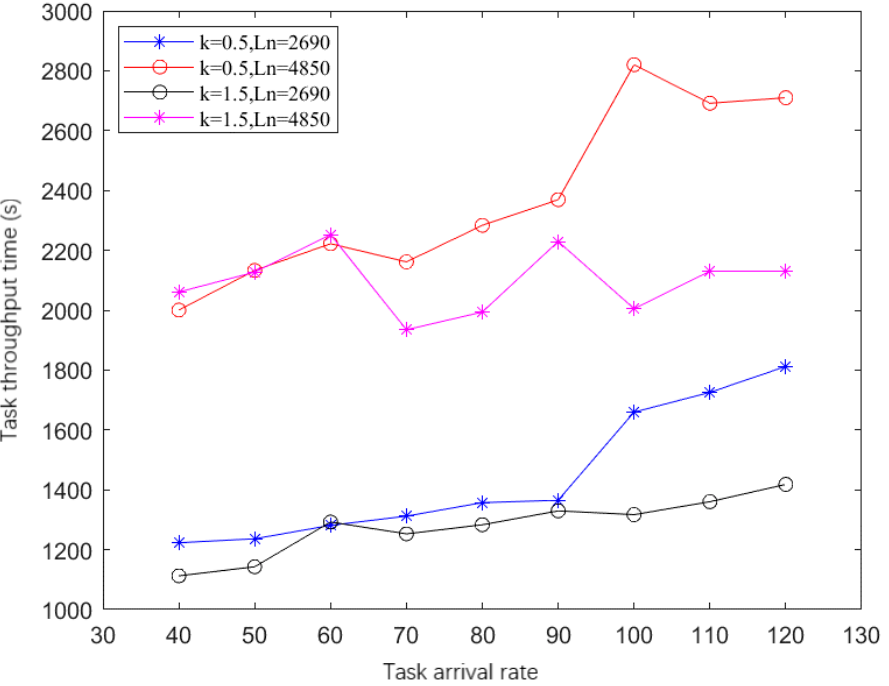
Figure 10. The Influence of the length–width ratio and the storage spaces on system performance.